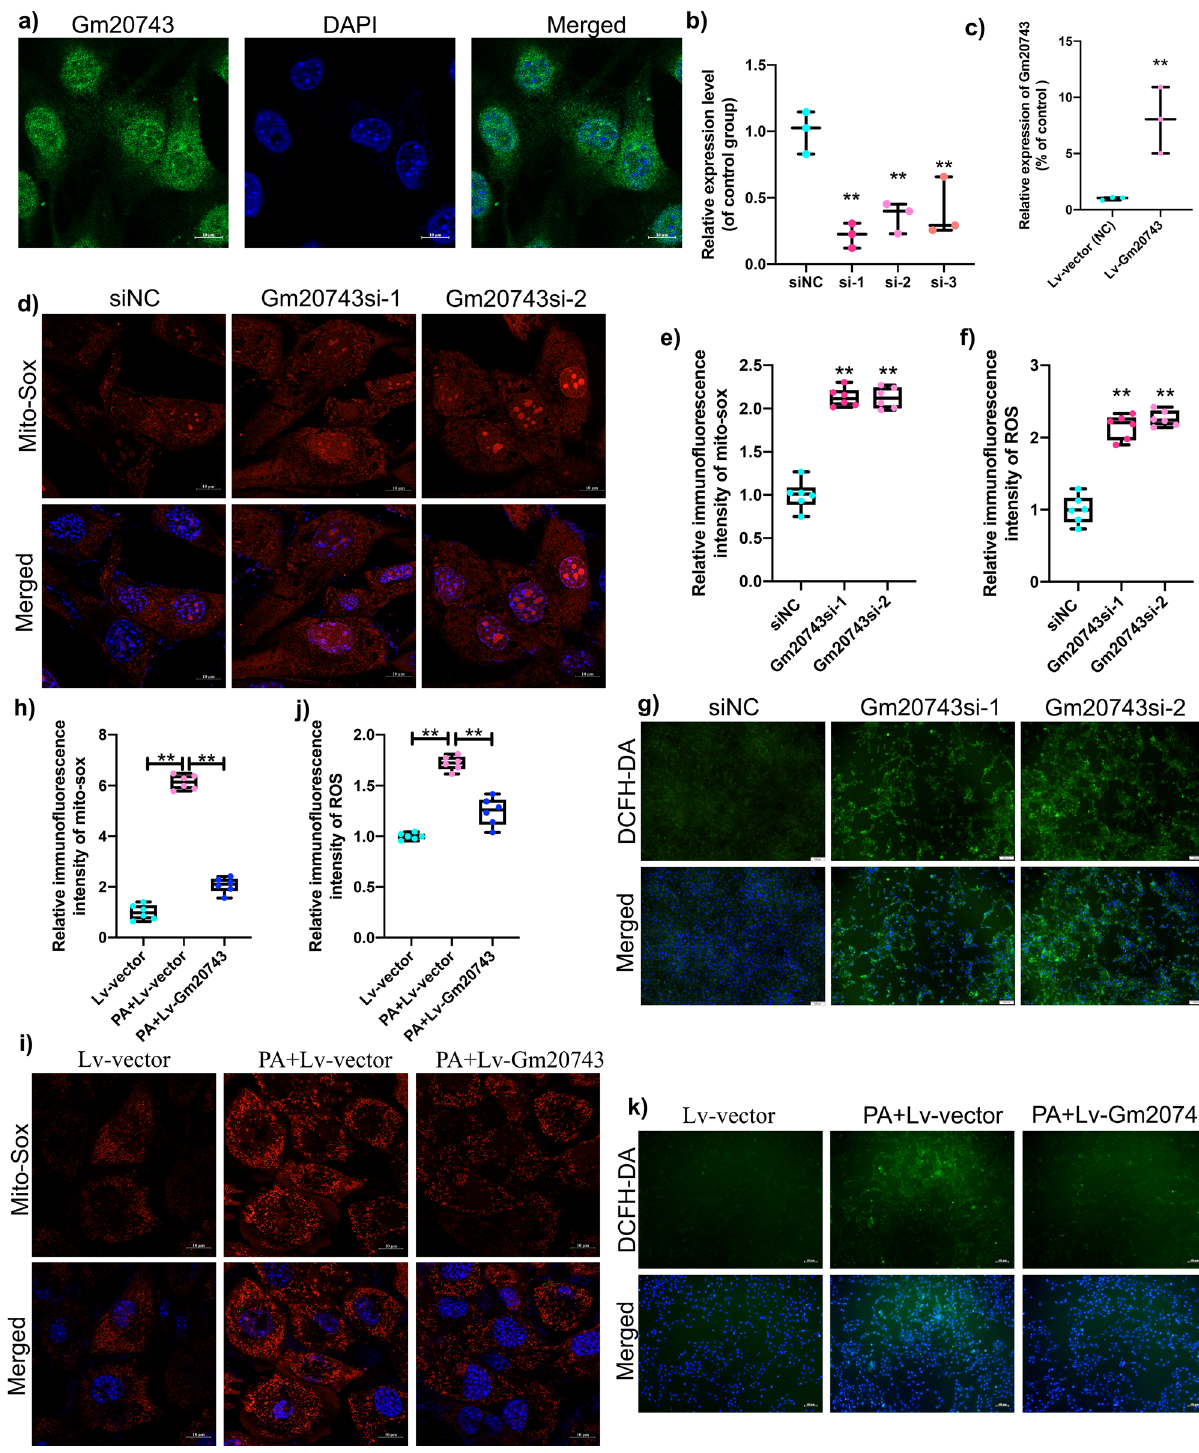
Fig. 9 LncRNA Gm20743 regulates mitochondrial function and redox homeostasis in C2C12 cells. a Fluorescence in suit hybridization was used to observe the distribution of Gm20743 in C2C12 cells. The expression of Gm20743 in C2C12 cells transfected with Gm20743-siRNA ( b ) and Lv-Gm20743 ( c ) was determined by RT-qPCR. Mito-Sox staining was applied to detect mitochondrial ROS levels in C2C12 cells with Gm20743-siRNA ( d , e ), scale bar = 10 μ m. DCFH-DA staining was performed to evaluate intracellular ROS levels in C2C12 cells with Gm20743-siRNA ( f , g ), scale bar = 100 μ m. Mito- Sox staining was applied to detect mitochondrial ROS levels in C2C12 cells with Lv-Gm20743 ( h , i ), scale bar = 10 μ m. DCFH-DA staining was performed to evaluate intracellular ROS levels in C2C12 cells with Lv-Gm20743 ( j , k ), scale bar = 100 μ m. Data were expressed as mean ± S.D. Compared with the siNC or Lv-vector (NC) group, * P < 0.05 ** P < 0.01. Note: si-1: Gm20743siRNA-1; si-2: Gm20743siRNA-2; si-3: Gm20743siRNA-3; DCFH-DA: 2 ’ , 7 ’ - dichloro fl uorescein-diacetate; ROS: reactive oxygen